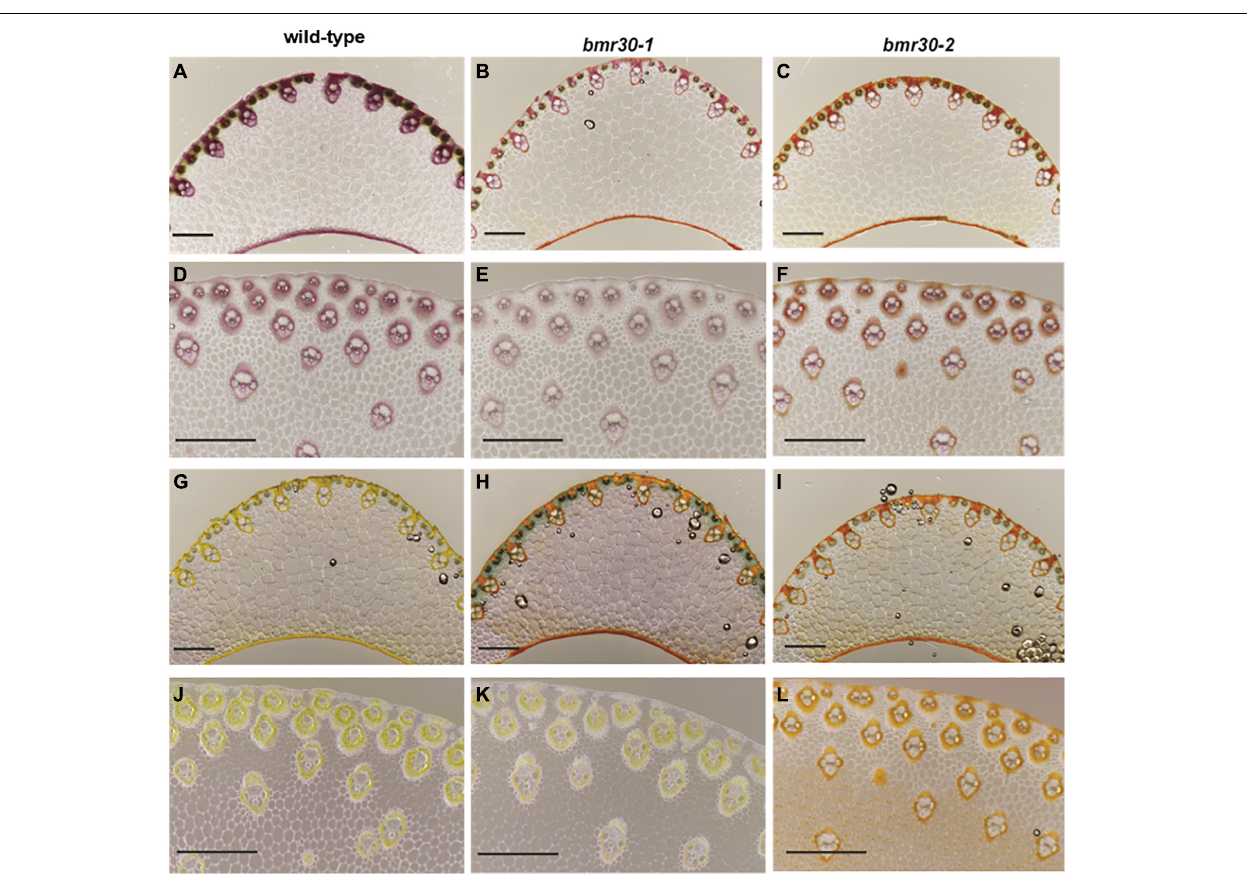
FIGURE 4 | Visualization of lignification using phloroglucinol (A–F) and vanillin-HCl (G–L) staining of leaf midrib (A–C,G–I) and stalk (D–F,J–L) tissues from wild-type (BTx623), bmr30-1 , and bmr30-2 plants. Scale bar = 500 µ m for both leaf midrib and stalk tissue. Leaf midrib tissue was observed at 40 × magnification, stalk tissue was observed at 80 × magnification using an Olympus BX-51 light microscope (Olympus